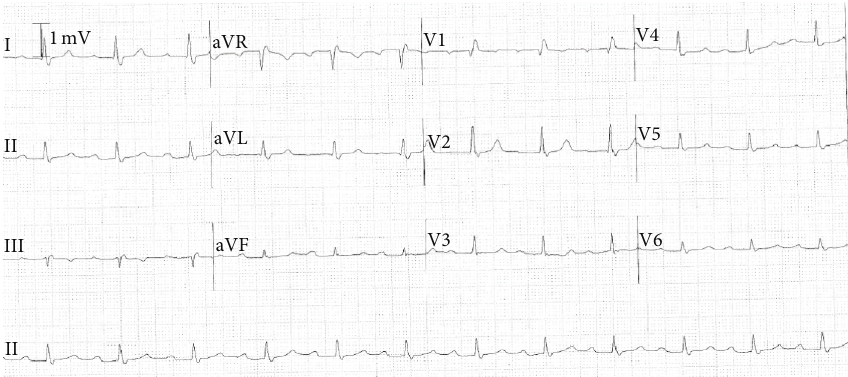
Figure 1: Patient’s EKG demonstrating new onset 1st degree heart block with PR interval of ca.